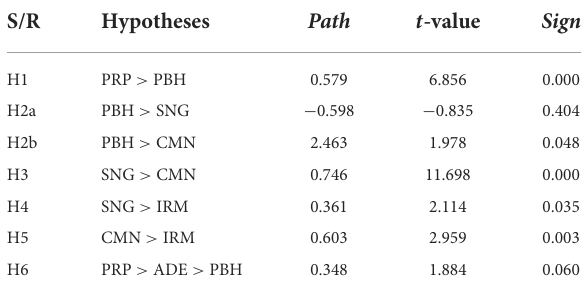
TABLE 6 Hypotheses testing (regression